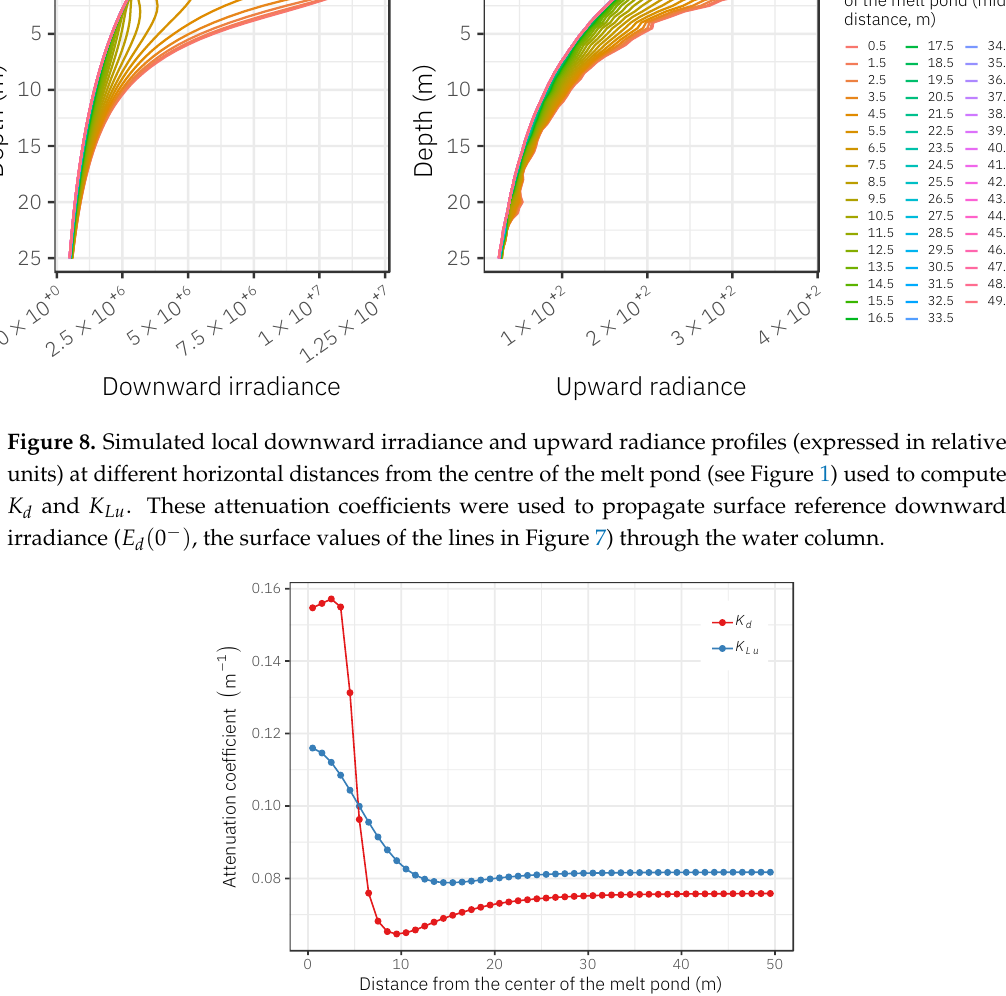
Figure 9. Diffuse attenuation coefficients calculated from local downward irradiance and upward radiance profiles simulated at different distances from the centre of the melt pond (see Figure 8).